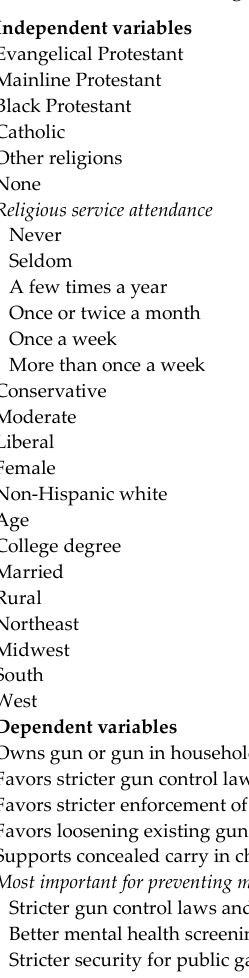
Table 1. Weighted descriptive statistics a .